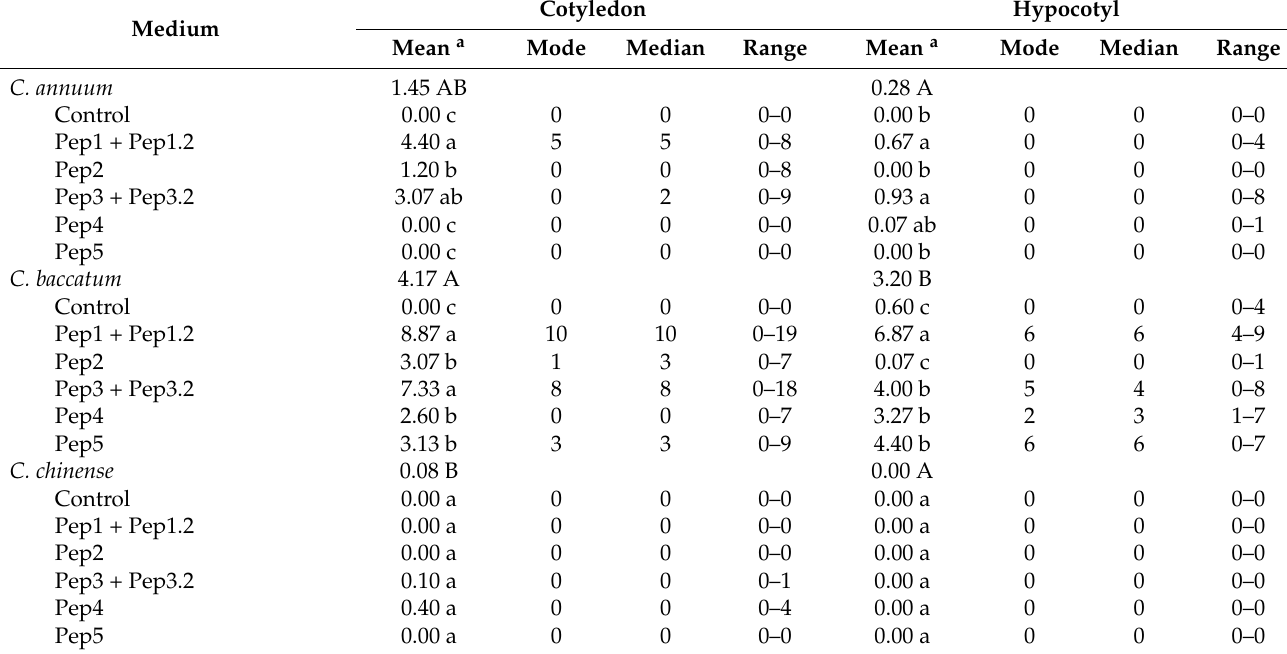
Table 6. Organogenic response in cotyledon and hypocotyl explants of Capsicum spp. Mean, mode, median and range of the number of shoots per explant ( n ) after two months of culture for each type of explant, depending on the medium used for regeneration. An experimental session was carried out with three replicates for each combination of factors (except C. chinense cotyledon, for which only two replicates were made due to the lack of plant material) and five explants per